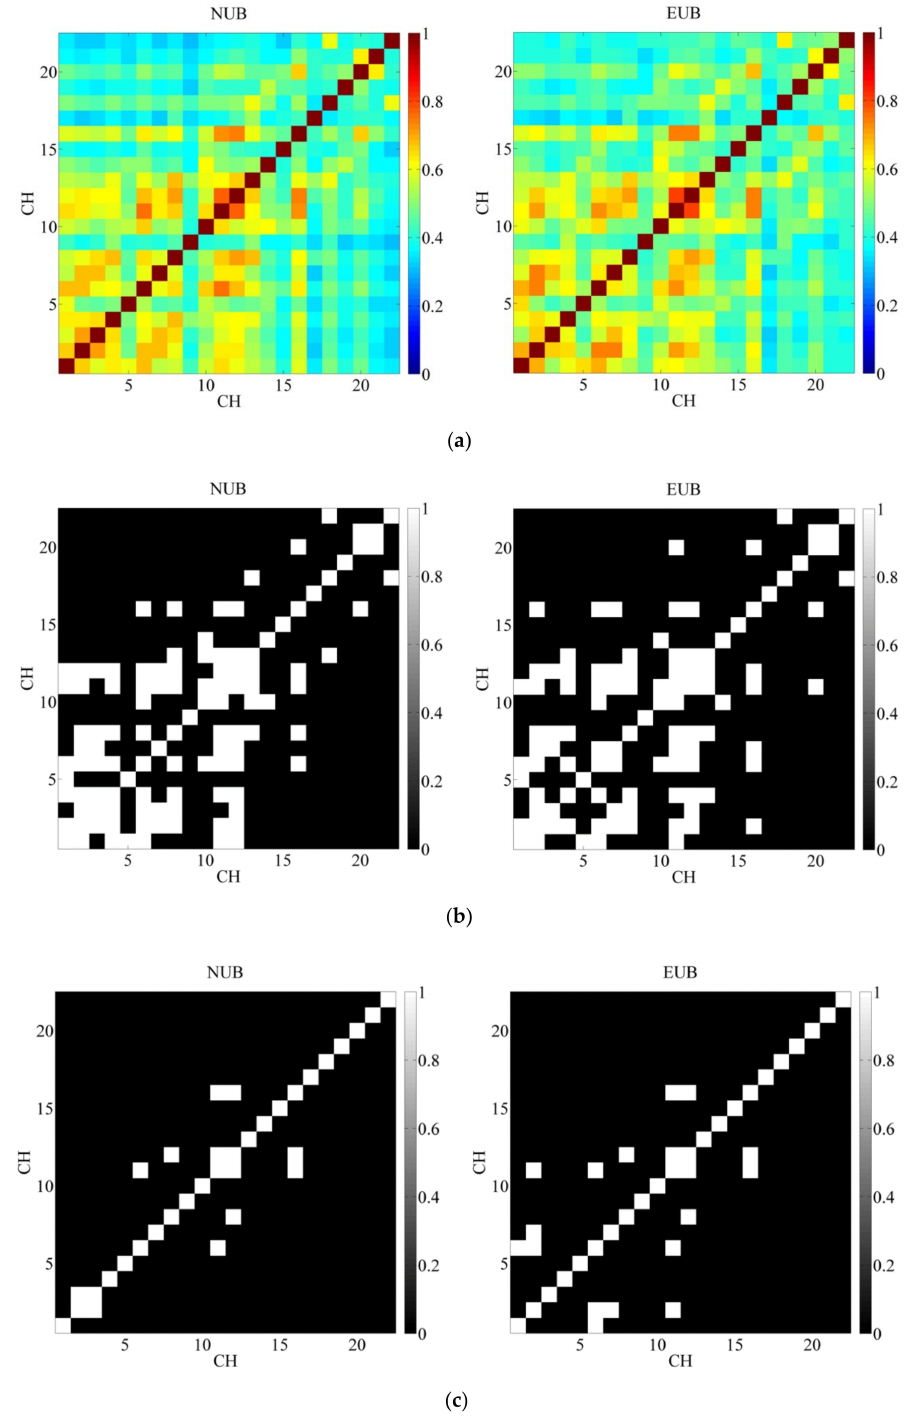
Figure 2. ( a ) Functional connectivity matrices between any two channels for NUB and EUB. ( b ) Binary matrices with COR = 0.5. ( c ) Binary matrices with COR =